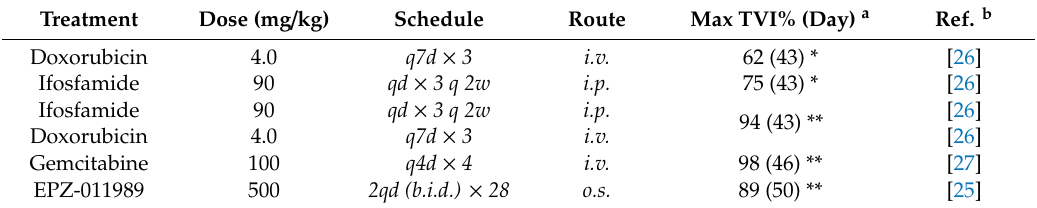
Table 1. Pharmacological treatment and tumor responses of ES-1 PDX to di ff erent agents.